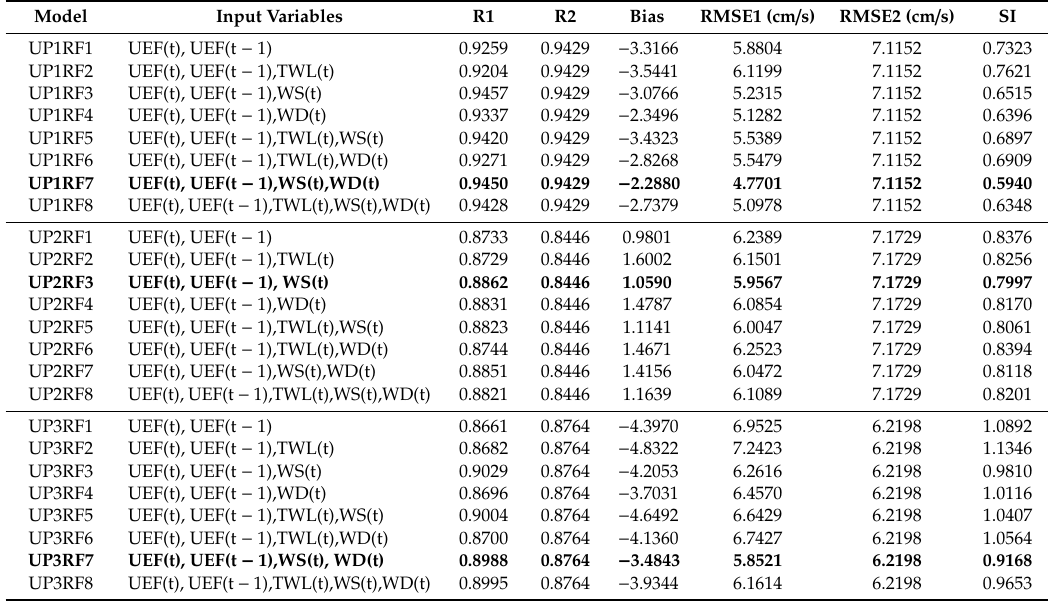
Table 4. Statistics of zonal surface velocity component (testing